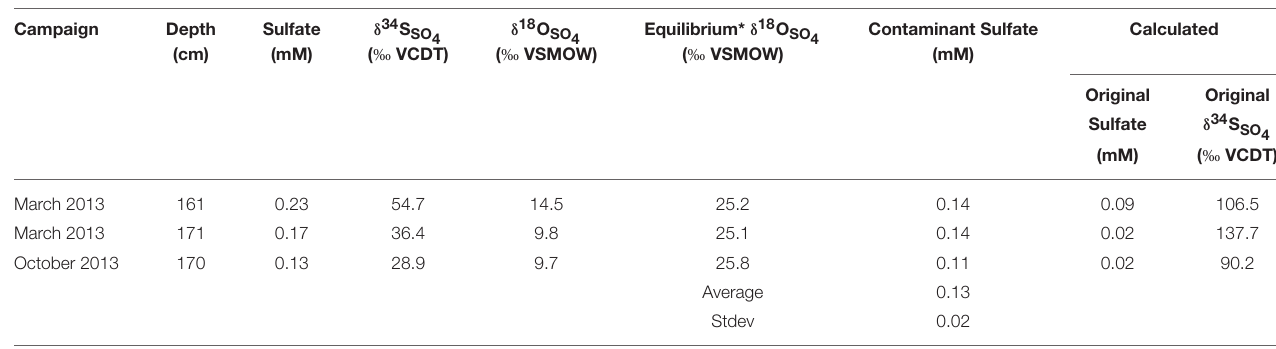
TABLE 5 | Contaminant mixing